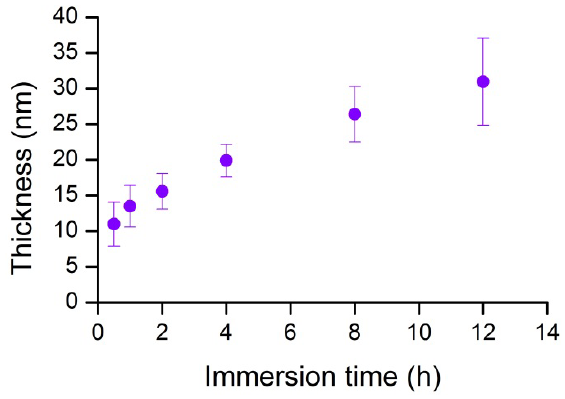
Figure 2. Effect of the immersion time (25 °C, phosphate buffer pH 8.5, dopamine = 2 g/L) on the polydopamine coating thickness as determined by ellipsometry in air.